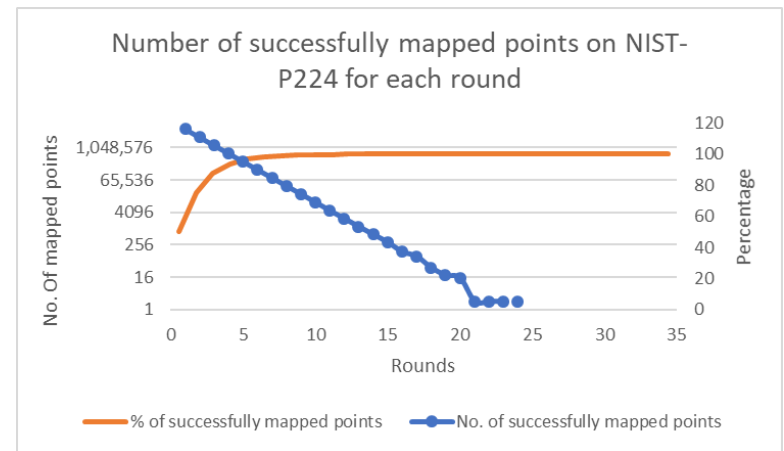
Figure 7. Case 2—Successfully mapped points count to nistP224.